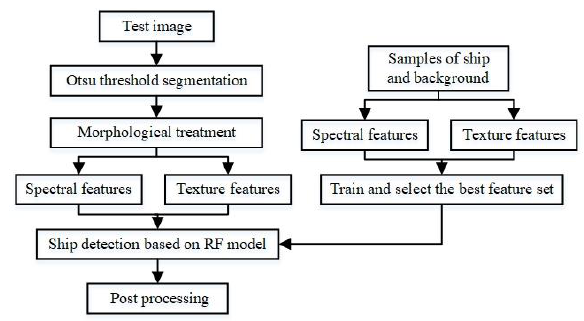
Figure 1. Flowchart of the proposed algorithm